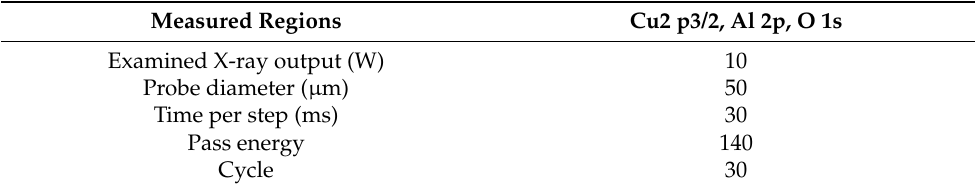
Table 2. XPS parameter of pure metals oxide film